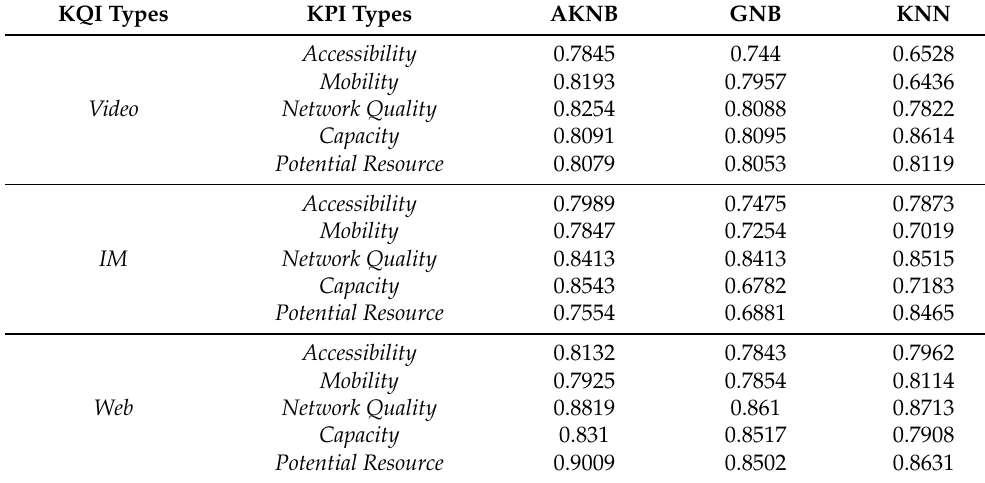
Table 5. Algorithm comparison for three service KQIs’